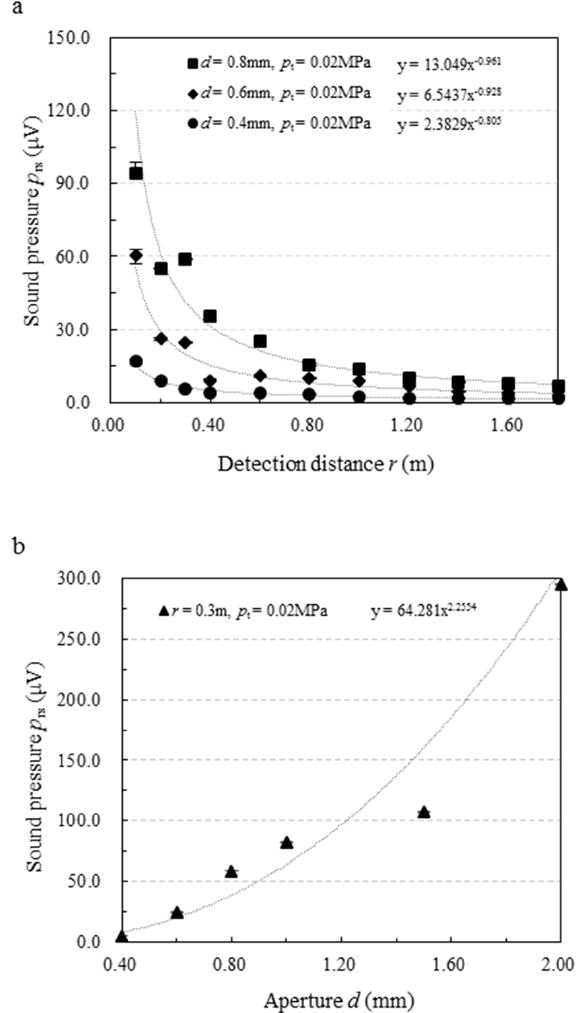
Figure 4. Effects of detection distance and leak aperture on sound pressure: ( a ) p rs vs. r ; ( b ) p rs vs. d .